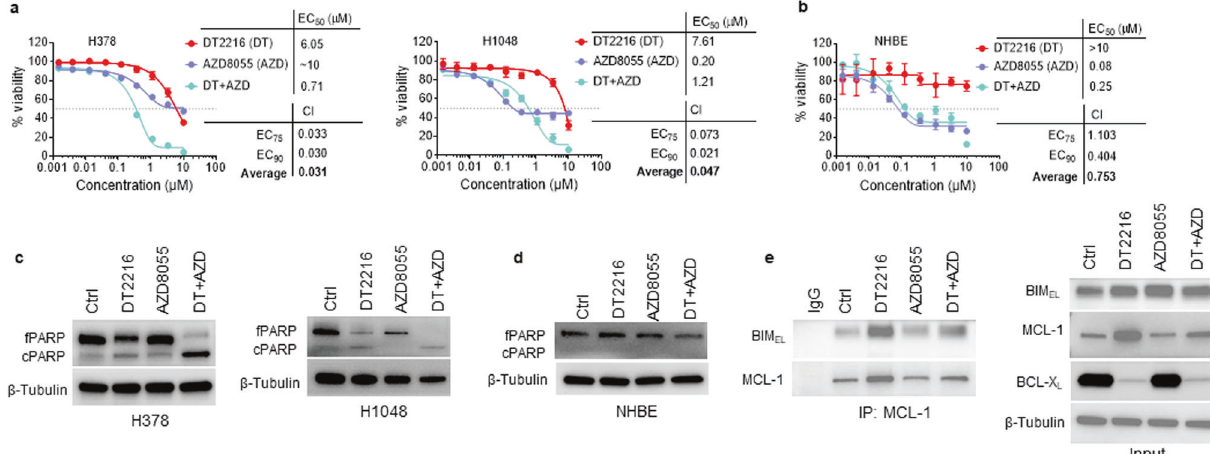
Fig. 4 DT2216 + AZD8055 combination synergistically kills BCL-X L /MCL-1 co-dependent SCLC cells through disruption of MCL-1/BIM interaction. a , b Viability of H378 and H1048 SCLC ( a ) and NHBE ( b ) cells after they were treated with increasing concentrations of DT2216 (DT) or AZD8055 (AZD) or their combination (1:1 ratio) for 6 days. EC 50 and CI values are shown. The data presented in a and b are mean ± SD from a representative experiment ( n = 3 replicate cell cultures). Similar results were obtained in two additional independent experiments. c , d Immunoblot analyses of full-length PARP (fPARP) and cleaved PARP (cPARP) in SCLC H378, H1048 ( c ), and NHBE ( d ) cell lines after they were treated with 1 µM each of DT2216 or AZD8055 or their combination for 24 h. e Immunoprecipitation analysis of MCL-1 followed by immunoblotting of BIM and MCL-1 in H1048 cells after they were treated with 1 µM each of DT2216 and/or AZD8055 for 24 h. Immunoblot analyses of BIM, MCL-1, and BCL-X L in input samples are shown on the right. The uncropped immunoblot images related to this fi gure are provided in the “ Supplemental Material ” fi